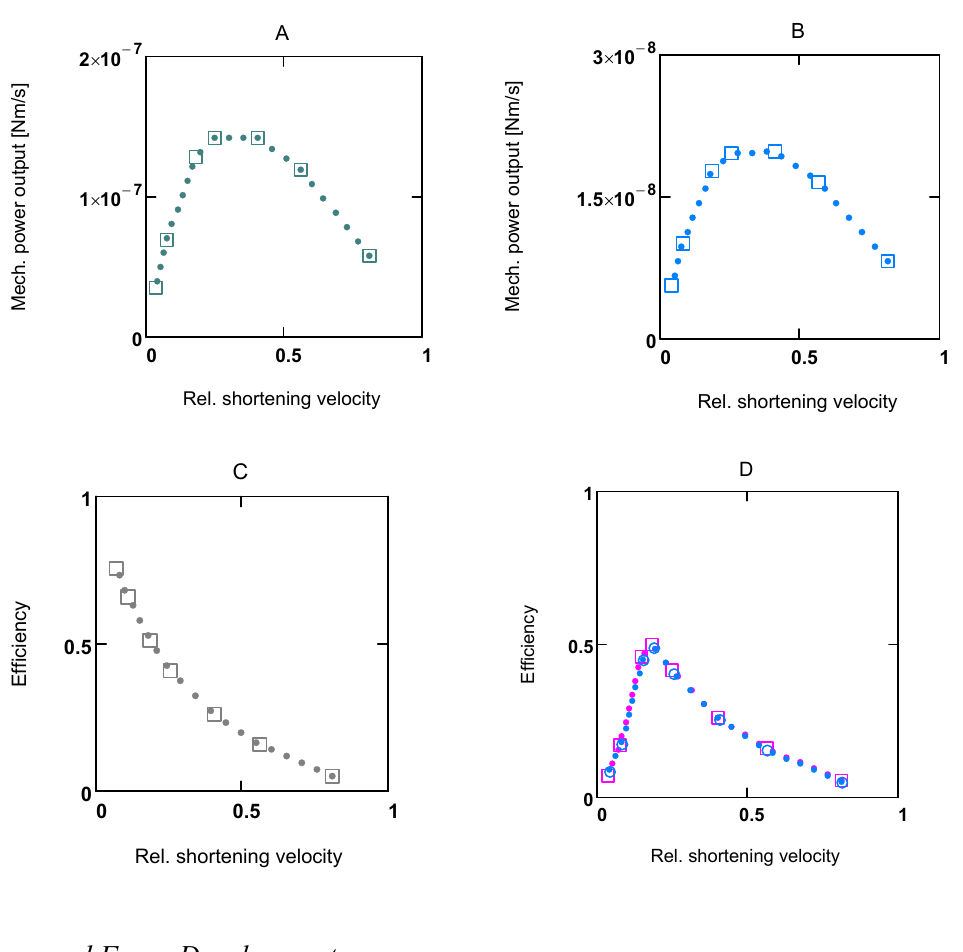
Figure 3. Power output and efficiency at two different Ca 2+ concentrations. ( A) and (C) [Ca 2+ ] = 1.06 µM; (B) [Ca 2+ ] = 0.36 µM; C: under totally coupled conditions; ( D) (red (blue circles) efficiency at 0.36 µM [Ca 2+ ]. All plots squares) efficiency at 1.06 µM [Ca 2+ ] , are results from SIM GLYge